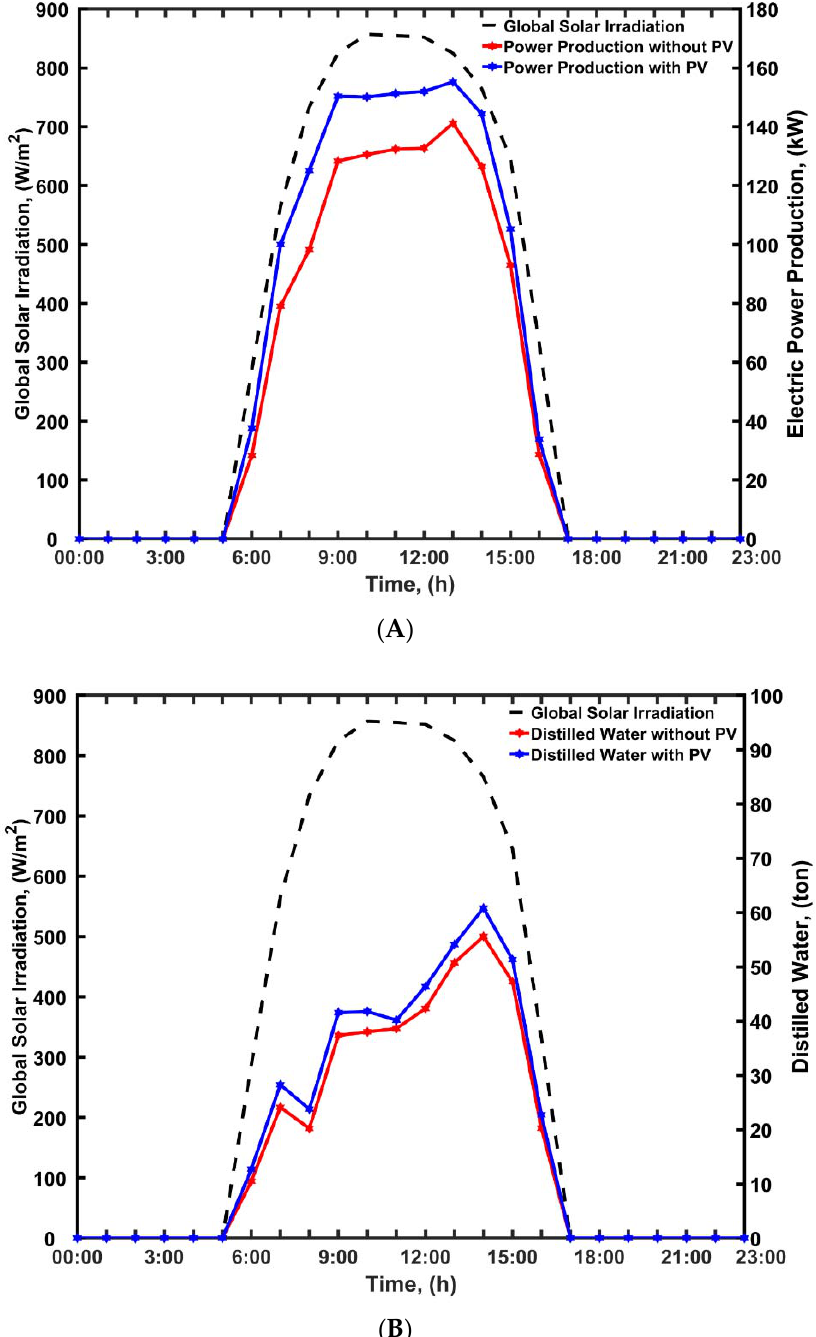
Figure 4. ( A ) Energy generation in SCPP and PV-SCPP; ( B ) desalinated water production in SCPP and PV-SCPP .